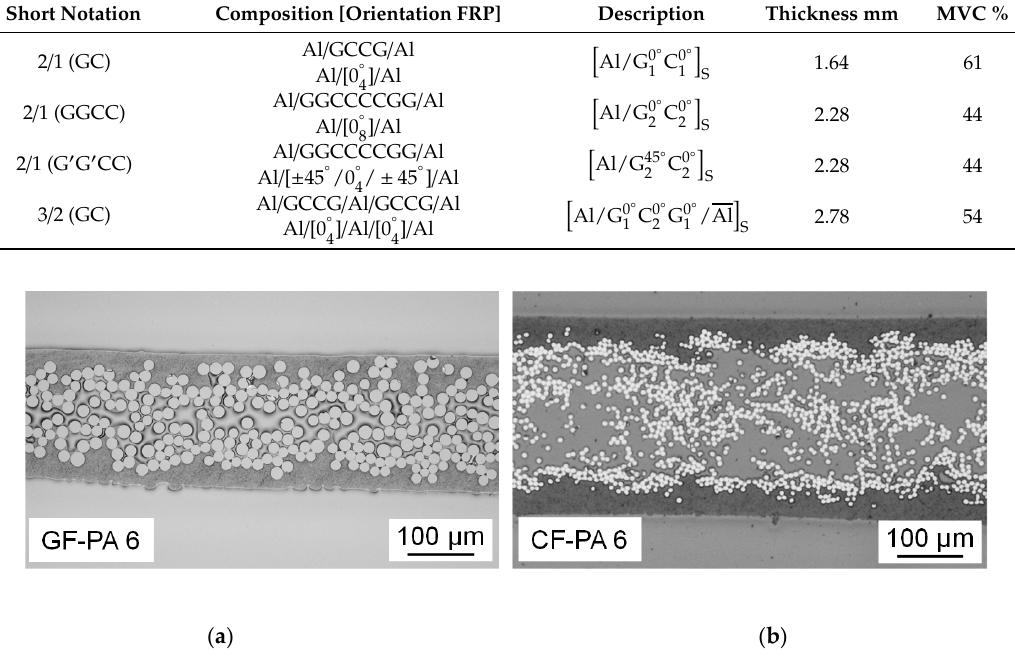
Figure 2. Cross section of the semi-finished FRP products: ( a ) glass and ( b ) carbon fibre-reinforced polyamide 6.